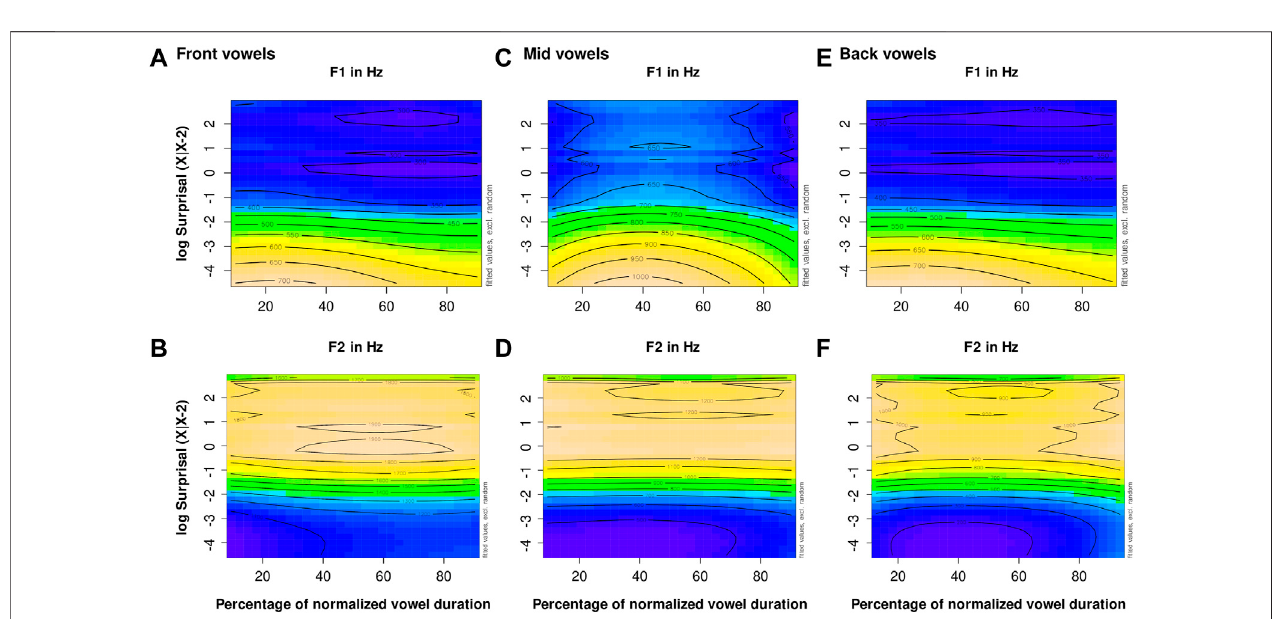
FIGURE 7 | Stressed vowels: heatmap of the interaction of triphone surprisal of the preceding context (log Surprisal (X | X-2)) and the measurement point on the trajectory of the fi rst formant (A) and the second formant (B) per the vowel categories front (C) , mid (D,E) , and back (F) .